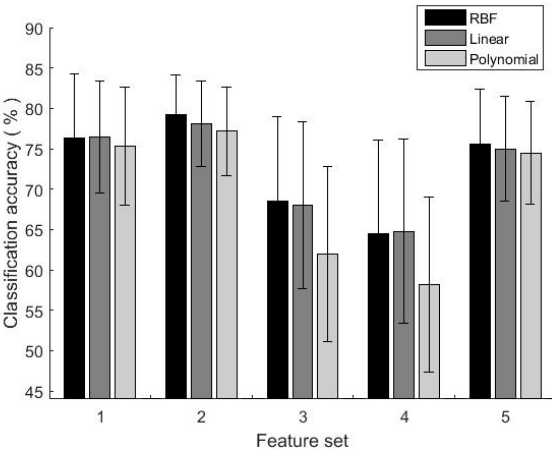
Figure 3. The classification accuracy using a single feature set.